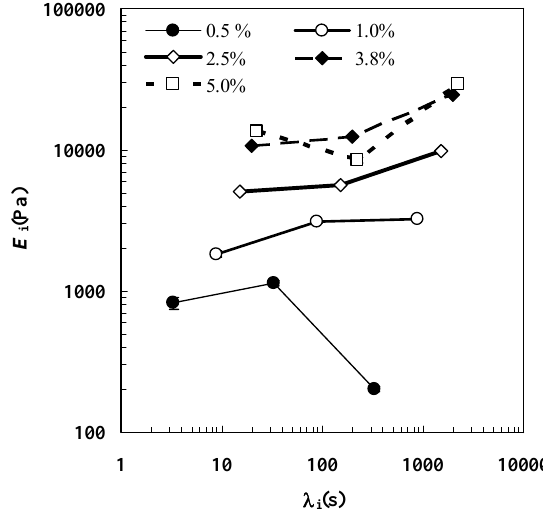
Figure 2. Relaxation spectra referring to C hydrogels. This picture relies on the data shown in Table